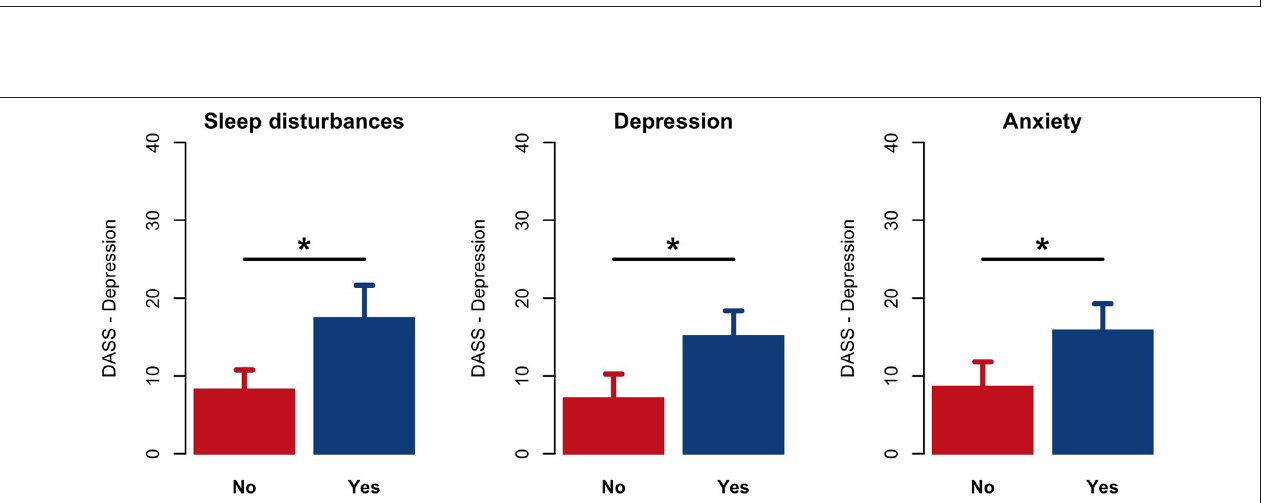
FIGURE 4 | Comparison results of DASS-21-Depression scores at T2 between those caregivers who answered “Yes” or “No” to the first survey items (T1) regarding the presence of insomnia (sleep disturbances), depression and anxiety. * p < 0.001.